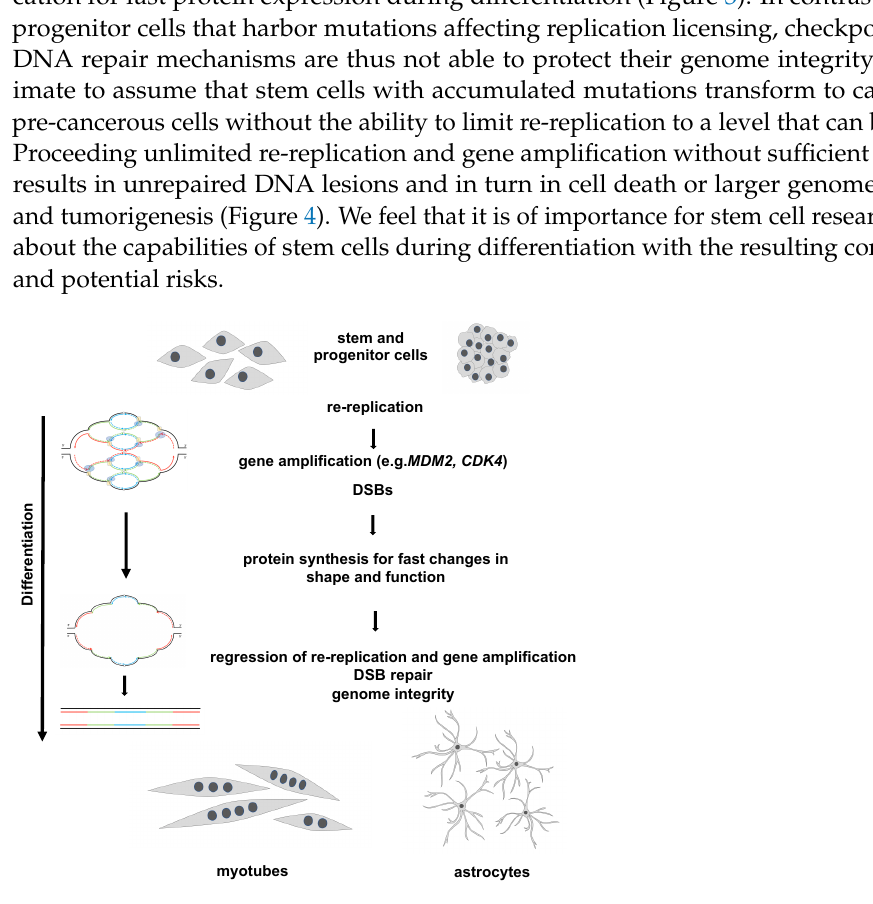
Figure 3. Transient re-replication and gene amplification during differentiation. The processes of re-replication and amplification during regular stem and progenitor cell differentiation are exemplarily shown for myoblasts and astrocytes. The re-replication causes gene amplification, which in turn enables increased protein synthesis. During the further differentiation both re-replication and gene amplification are ceased, and double strand break repair reinsures genome integrity. The scheme on the left-hand side explains how the onionskin-like structure can likely be resolved into duplicated DNA strands. Cell nuclei are indicated as filled dots.